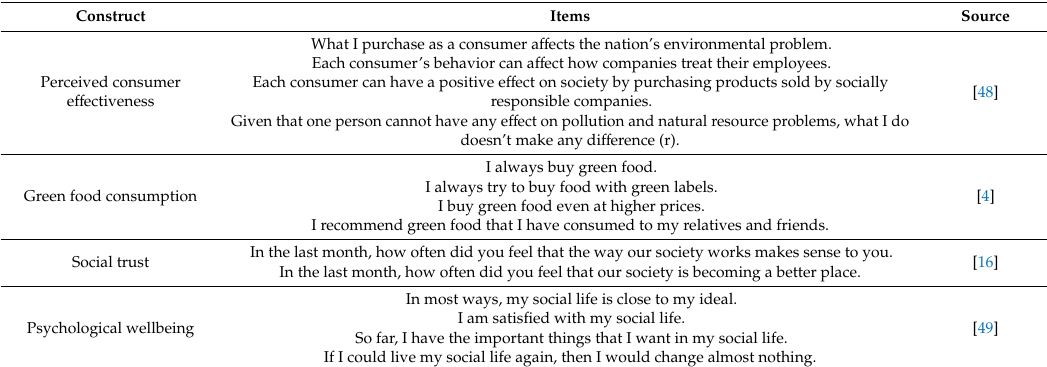
Table 1. Items and constructs of